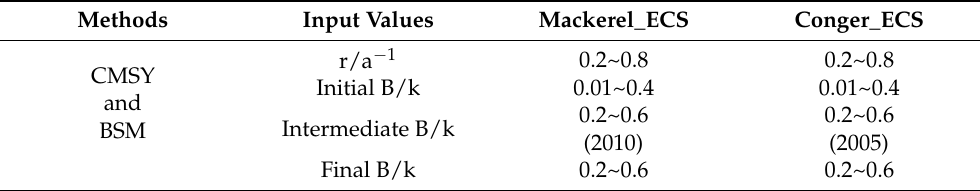
Table 3. Input values of models.